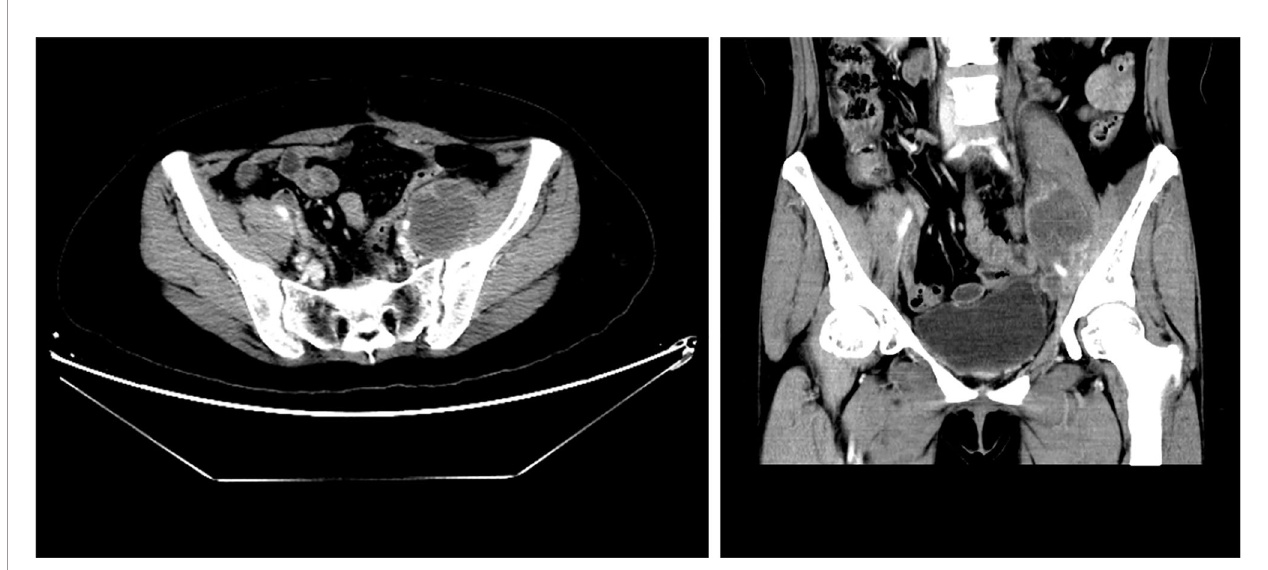
FIGURE 2 | Pelvic MRI on April 1, 2019. Coronal view showing an anterior abdominal wall metastasis after niraparib administration for 20